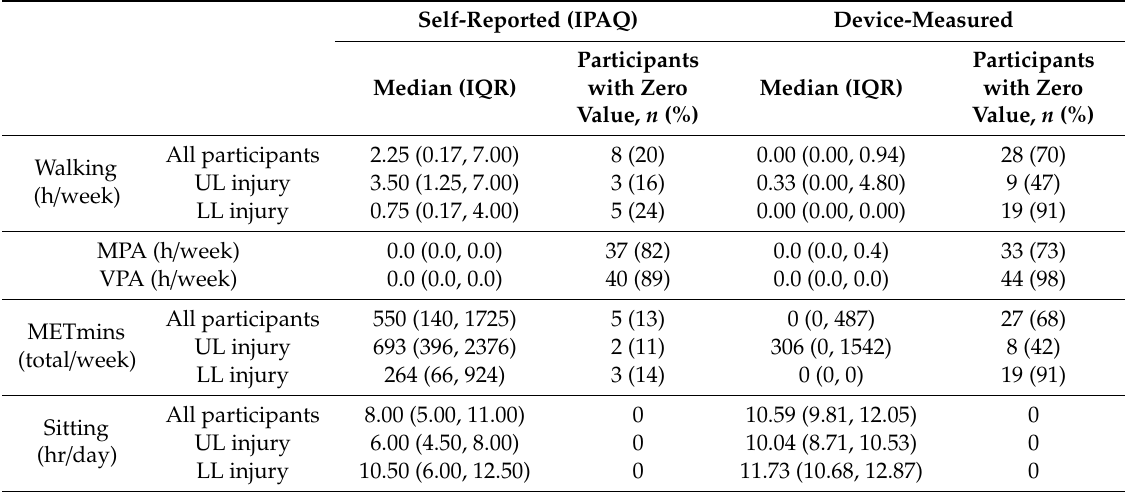
Table 2. Physical activity and sitting time data from the International Physical Activity Questionnaire– Short Form (IPAQ) and activity monitors by variable and injury location.